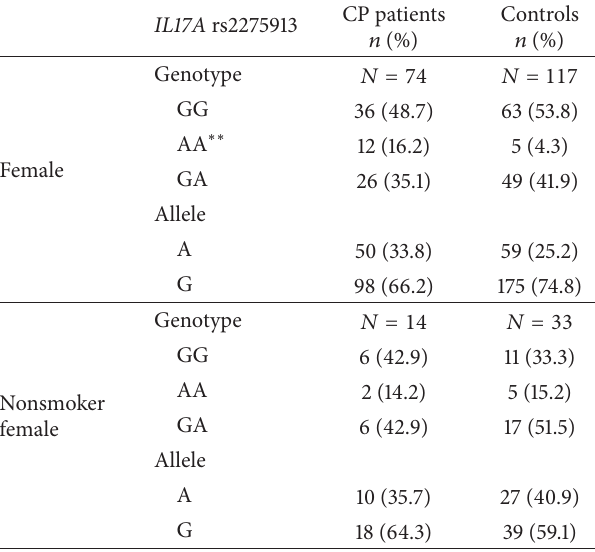
Table 3: IL17A genotype and allele frequencies in chronic periodon- titisBrazilianpatientsandcontrolsstratifiedaccordingtogender ∗ in the total samples and nonsmoking